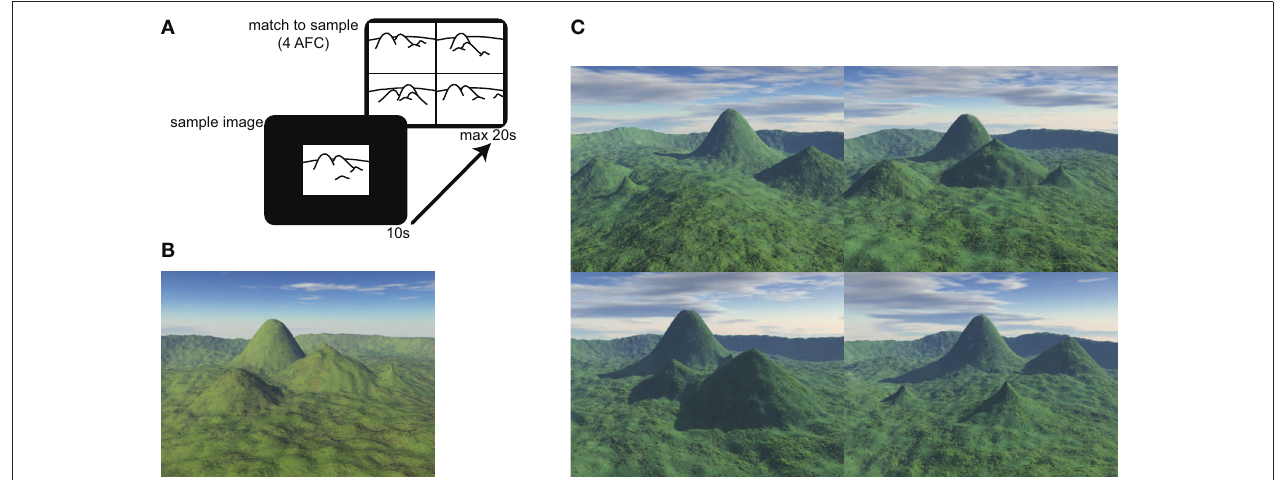
FIGURE 1 | FourMountainsTaskandexamplestimuli.(A) Thetestconsists of 30items.Ineachitem asampleimageispresentedfor 10s. Thefour alternativematchtosampletaskisthendisplayedforupto20s. (B) Exampleof sampleimage.Fourdistinctive hills arearrangedaroundthecamera’sfocal point,within asemicircular range. (C) Exampleoffouralternative forcedchoice